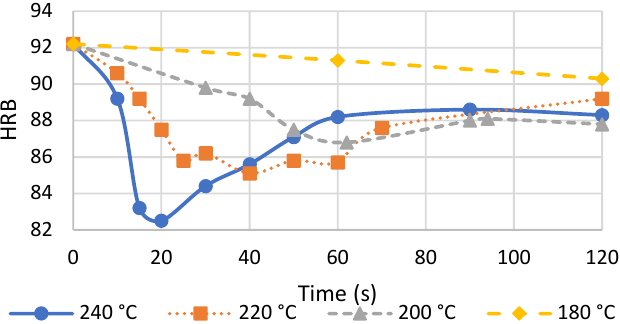
Figure 2. Retrogression hardness of AA7075; Reprinted from Publication [8], with permission from